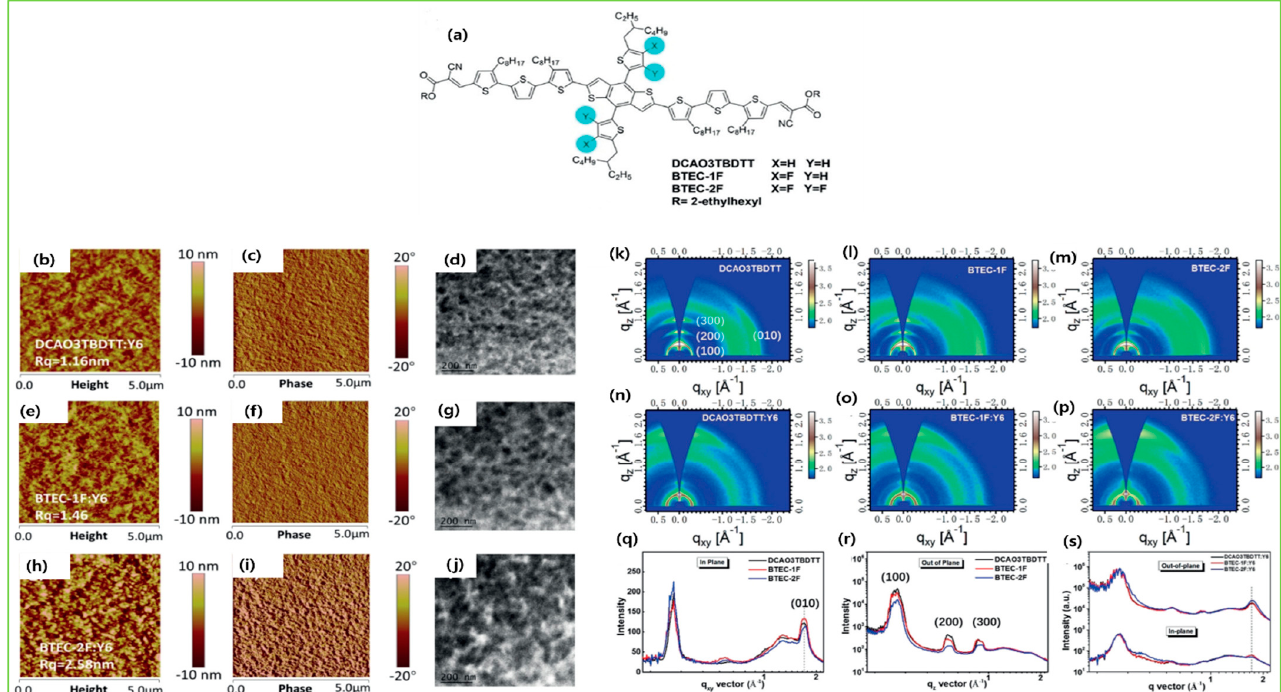
Figure 8. ( a ) Chemical structures of DCAO3TBDTT, BTEC − 1F, and BTEC − 2F. ( b , e , h ) AFM height images and ( c , f , i ) AFM phase images of the blend films for DCAO3TBDTT:Y6, BTEC − 1F:Y6, and BTEC − 2F:Y6, respectively. ( d , g , j ) TEM images. ( k – m ) 2D GIWAXS images of the neat films after thermal annealing. ( n – p ) Two-dimensional GIWAXS images of the blend films processed under optimal conditions. ( q – s ) One-dimensional plots of the neat and blend films extracted from 2D GIWAXS images along with out-of-plane and in-plane directions. Adapted with permission from Reference [24]. Copyright 2019, John Wiley and Sons.